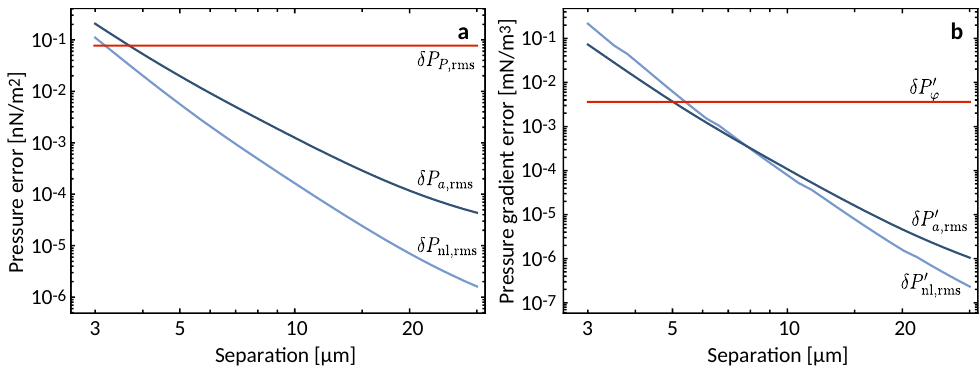
Figure A1. Amplitudes of the different contributions to seismic noise considering an integration time τ m = 600 s and statistical averaging over 100 measurements for RMS and phase noise errors. ( a ) errors on the pressure. ( b ) errors on the pressure